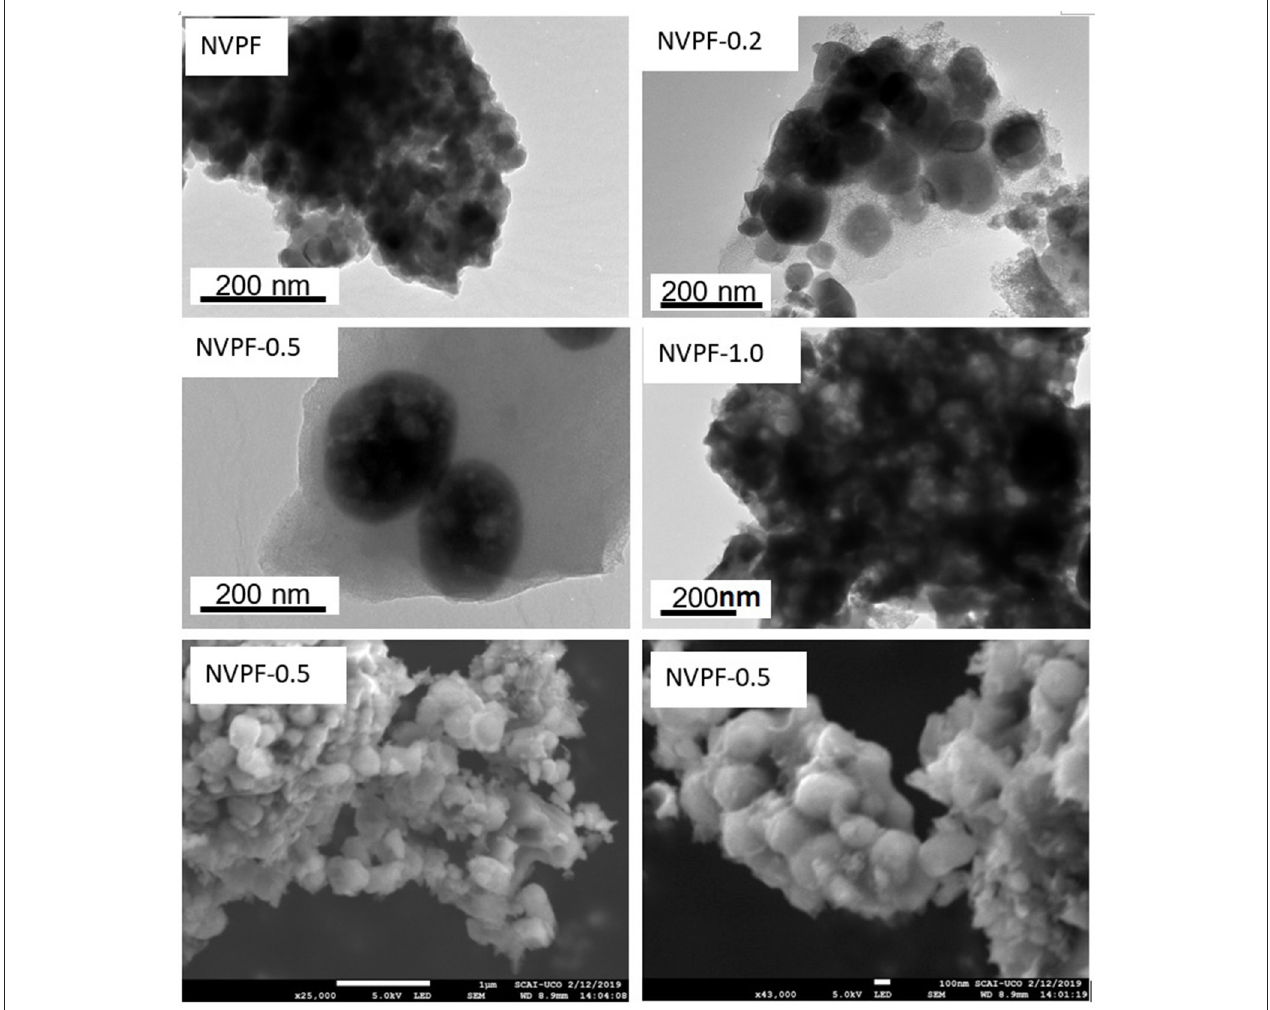
FIGURE 1 | TEM and SEM images of selected Na 3 V 2 (PO 4 ) 2 F 3 samples prepared with different amounts of CTAB